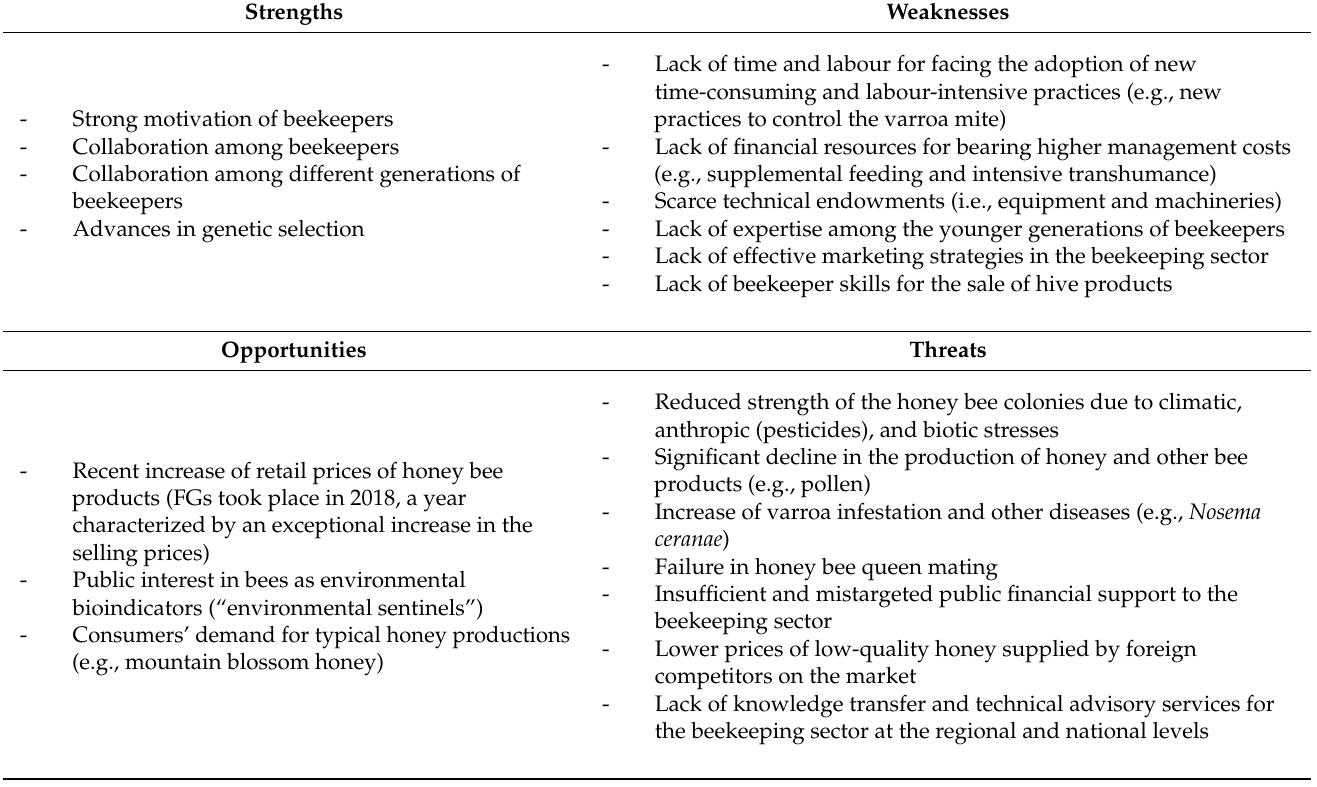
Table 2. Strengths, weaknesses, opportunities, and threats (SWOT) matrix of the beekeeping sector in the surveyed area.